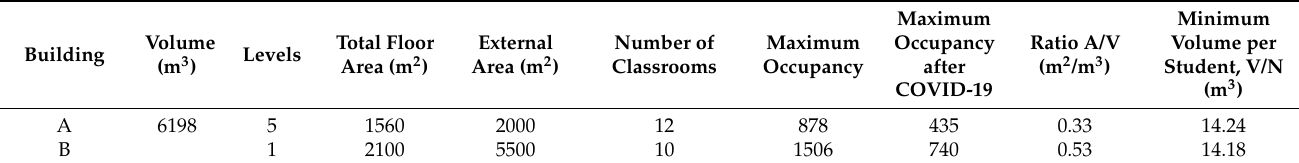
Table 1. The main data of the two structures.